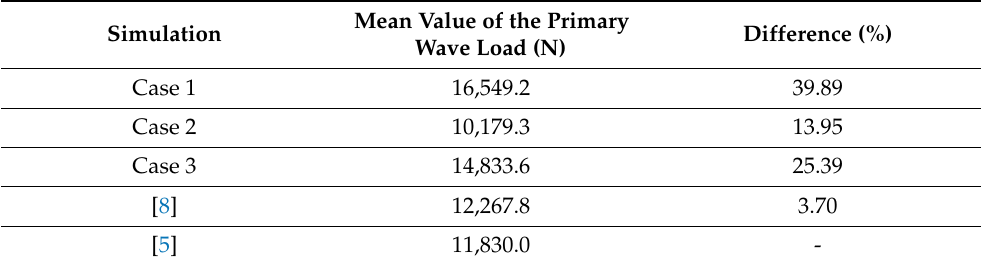
Figure 16. Comparison of the magnitude of the primary wave load for all simulation cases and the results of [5,8]. Table 13. Comparison of the magnitude of the primary wave load for all simulation cases.